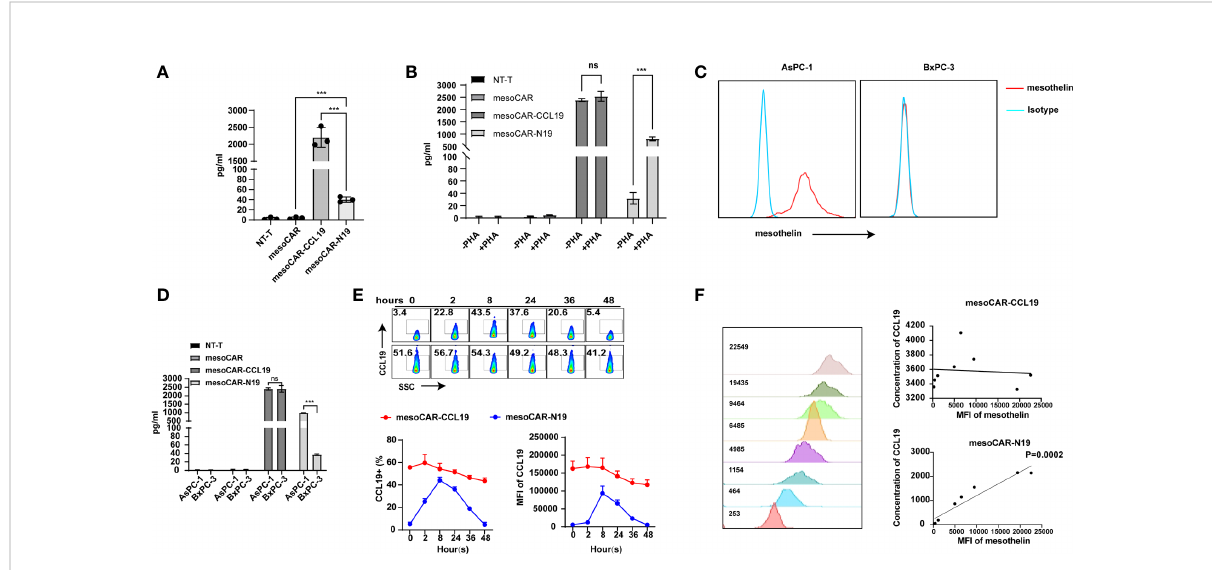
FIGURE 2 Identi fi cation of C-C motif chemokine ligand 19 (CCL19) expression. (A) Resting CCL19 secretion level measured by ELISA; (B) Detection of CCL19 secretion in chimeric antigen receptor T (CAR-T) cells before and after activation with PHA-L by ELISA; (C) Detection of mesothelin expression in the cancer cell lines; (D) Detection of CCL19 expression in CAR-T cells after co-culturing with AsPC-1 cells by ELISA; (E) Expression of CCL19 at different time points after co-culturing with AsPC-1 cells as detected by fl ow cytometry; (F) Correlation analysis